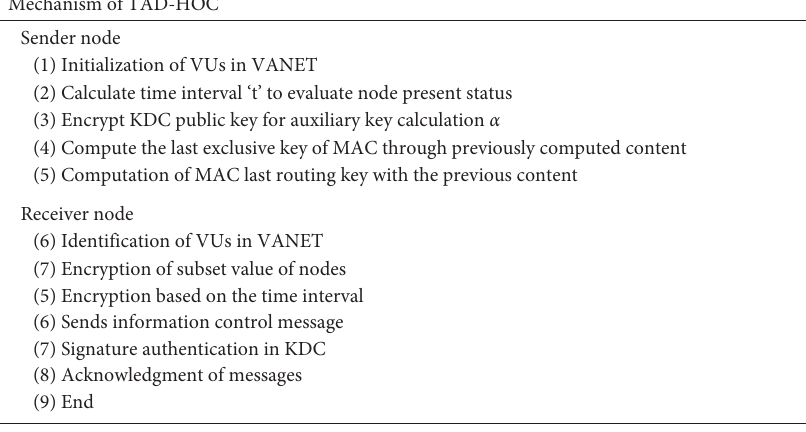
Figure 4: Mechanism for